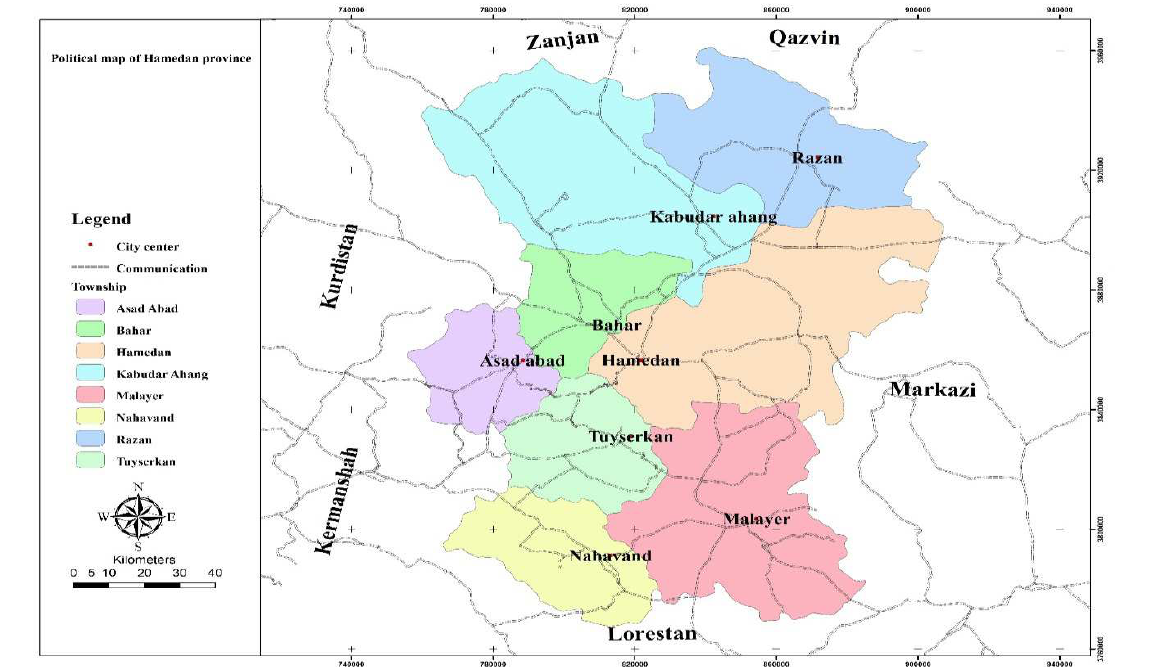
Figure 1. Location of Hamedan province in